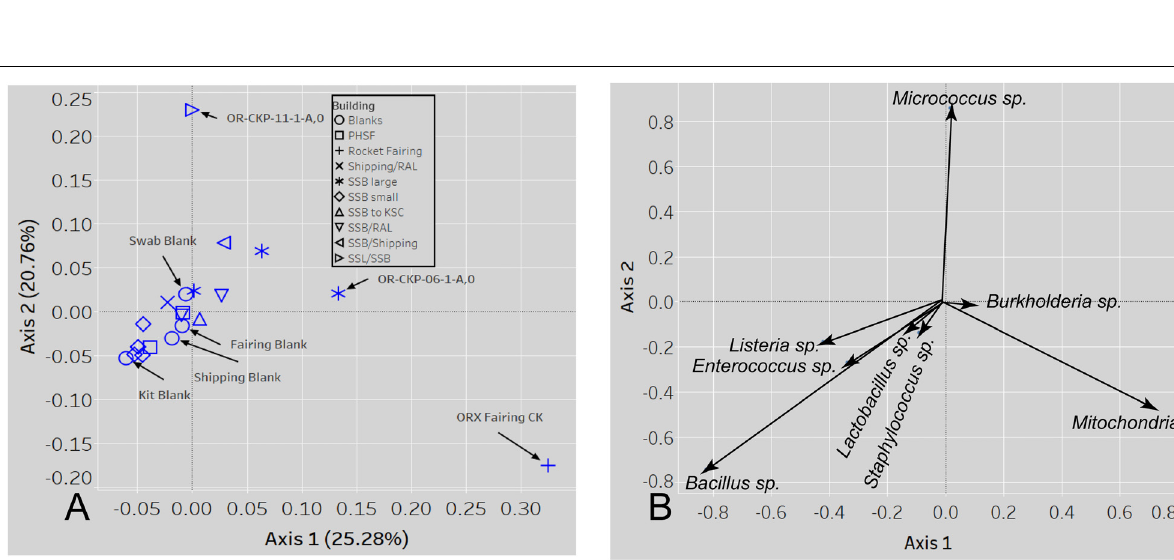
Frontiers in Microbiology |